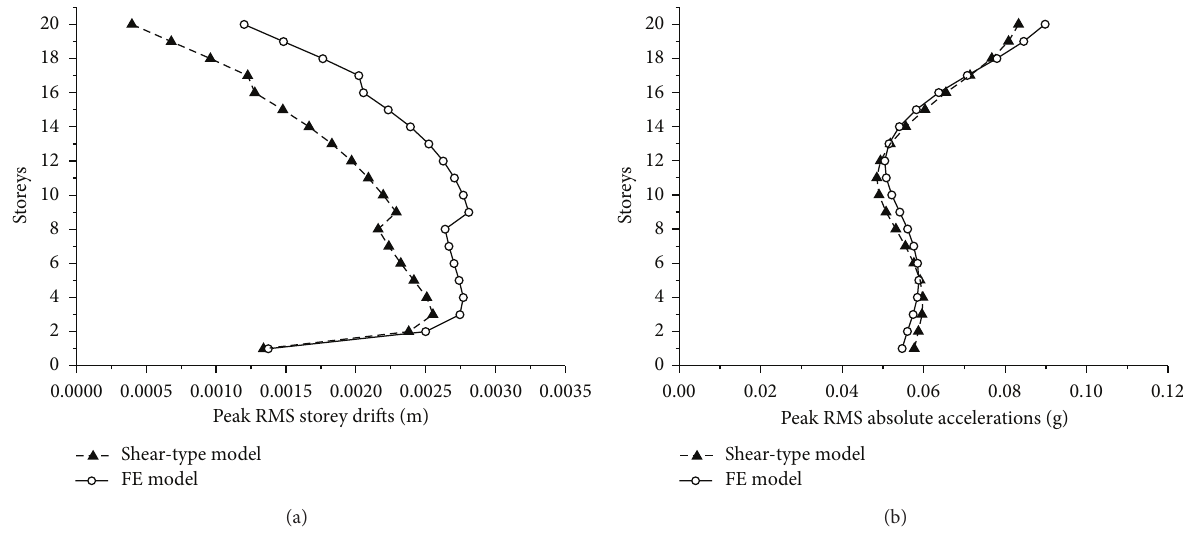
Figure 7: Comparison of the (a) peak RMS storey drifts and (b) absolute storey accelerations of the superstructure given by FE analysis with those given by the shear-type MDOF